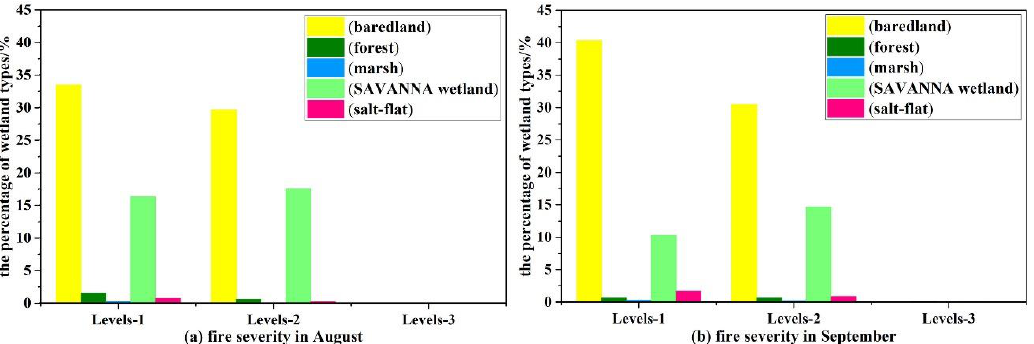
Figure 7. The fire severity and the percentage of wetland types: ( a ) is in August; ( b ) is in September. Note that Level-1 represents the low-severity burnt area, Level-2 represents the moderate-severity burnt area, and Level-3 represents the high-severity burnt area.